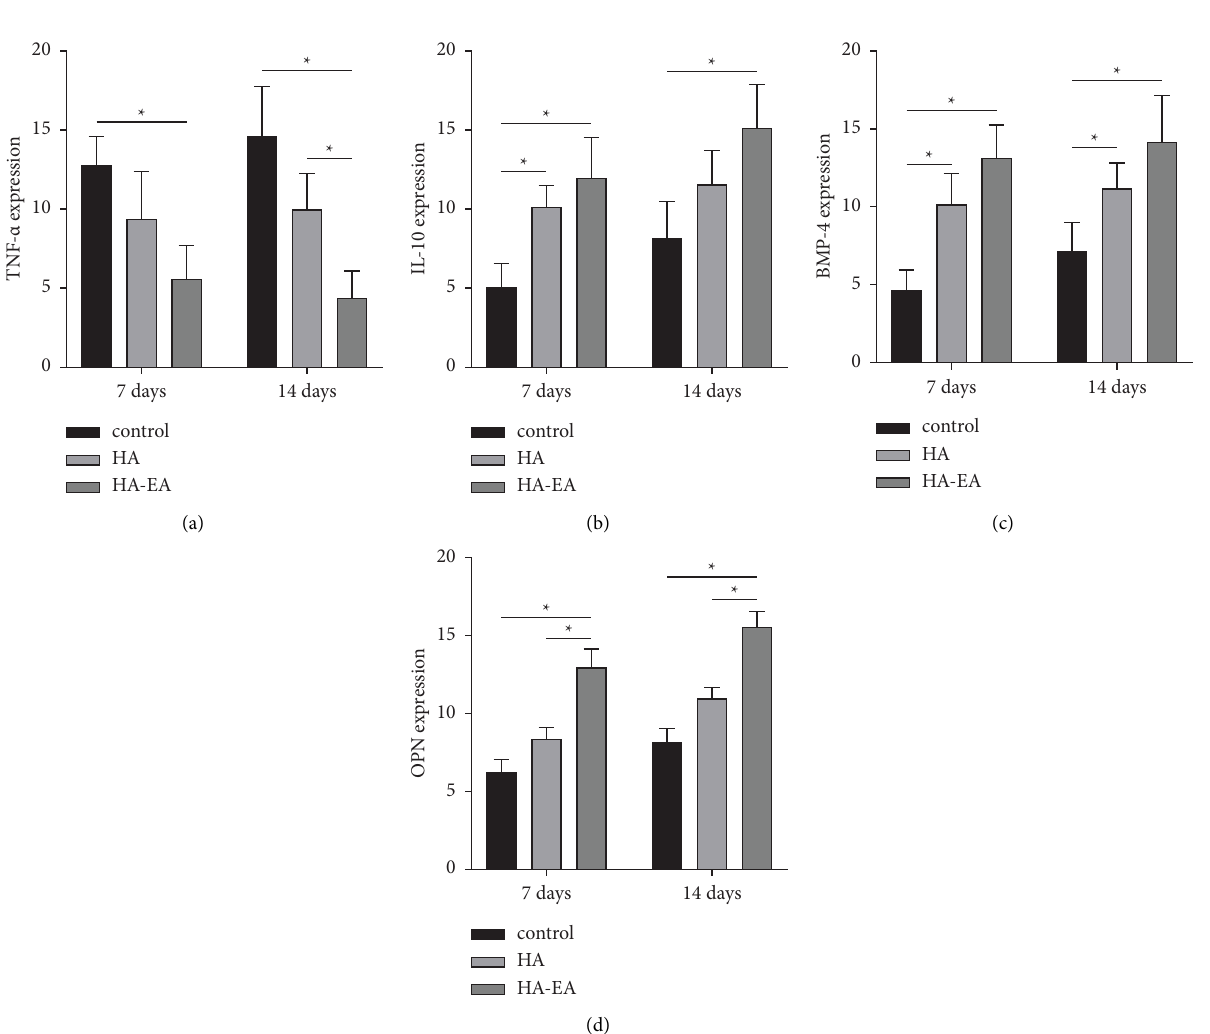
Figure 2: Te mean of the bone marker expression in each group. Te TNF- α (a), IL-10 (b), BMP-4 (c), and OPN (d) expressions. ∗ Indicate a value of signifcance using posthoc test as p < 0.05.